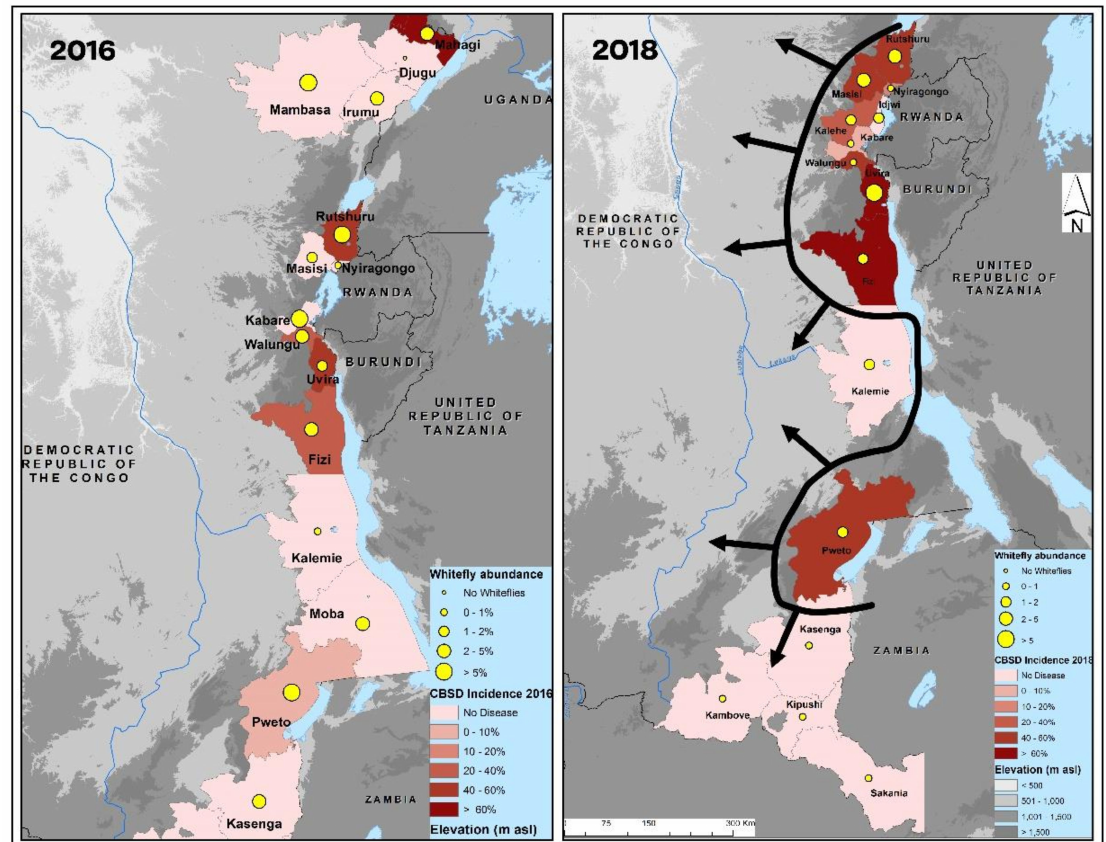
Figure 3. Maps illustrating the incidence of cassava brown streak disease (CBSD) and abundance of B. tabaci whiteflies on cassava in territories surveyed in 2016 and 2018 in eastern